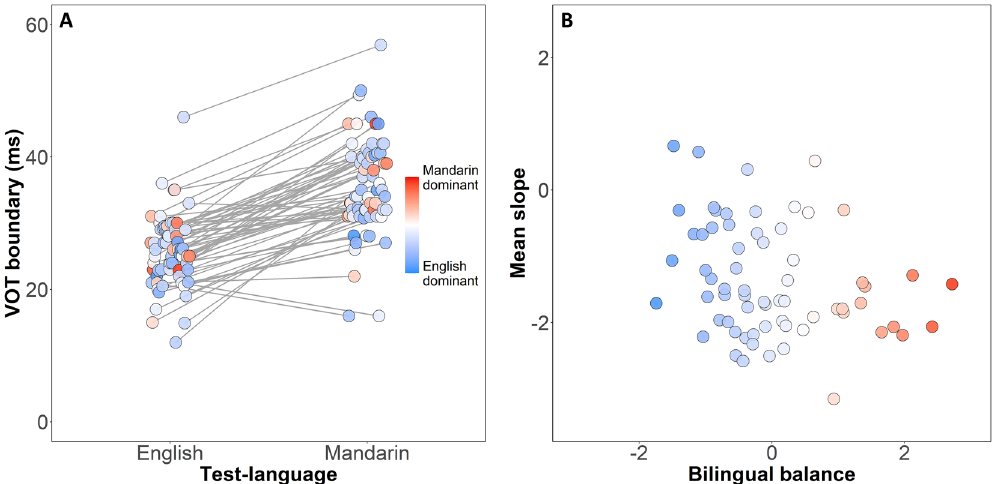
Figure 4. Results of GLMMs on VOT boundary and slope showing significant effects. ( A ) VOT boundaries for each participant across two languages. ( B ) Scatter plot of slope values (pooled across languages) with bilingual balance derived from PCA. Early bilingual balance shown in a color scale.